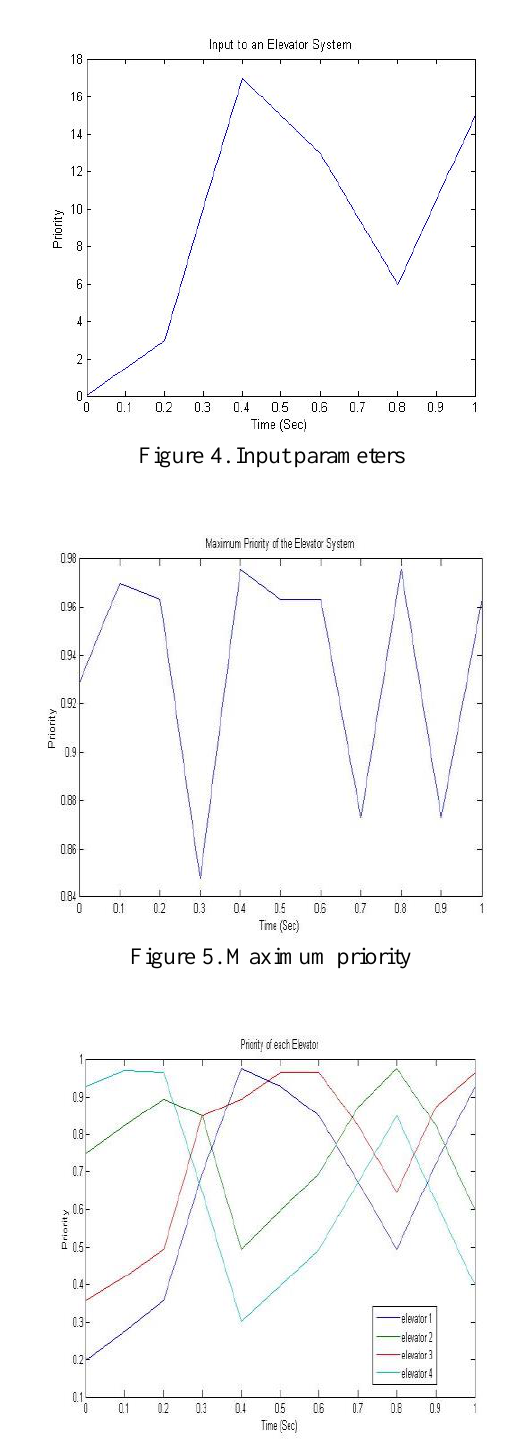
Figure 6. Priority of each